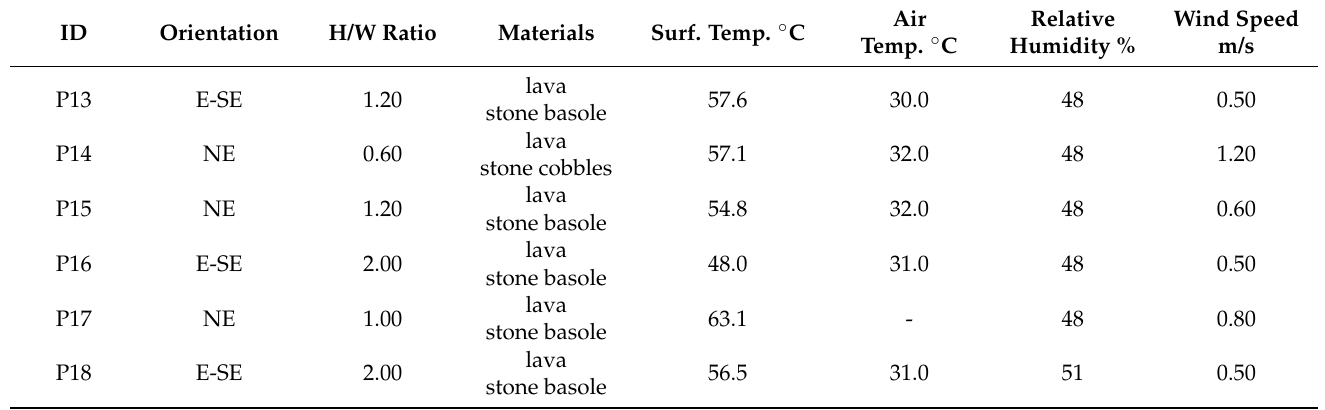
Table 1. Environmental data extract from the Historic Centre of Naples (August 2015, 13:00–15:00).